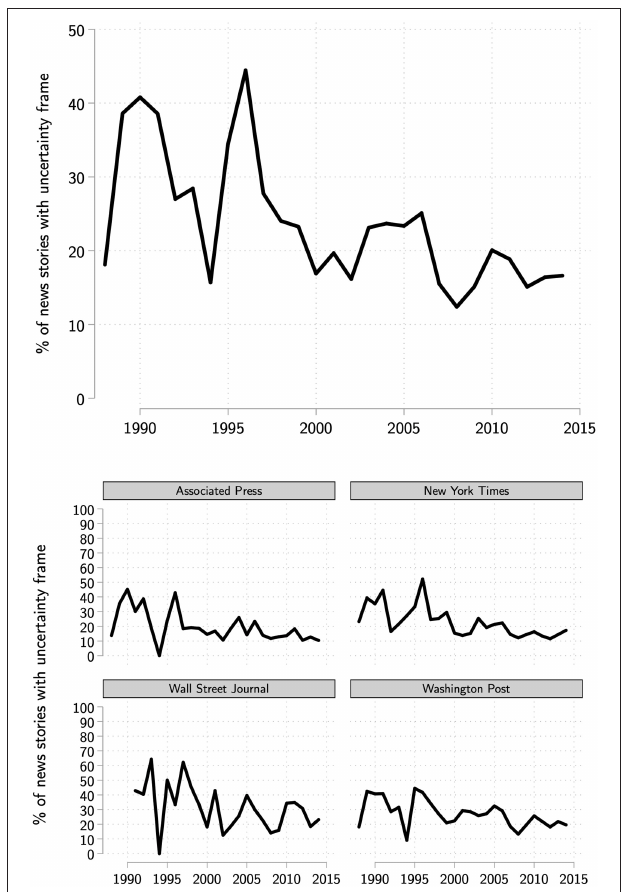
FIGURE 4 | Frequency of risk related language in climate change news coverage from 1988 to 2014 in our combined corpus (top panel) and by source (bottom